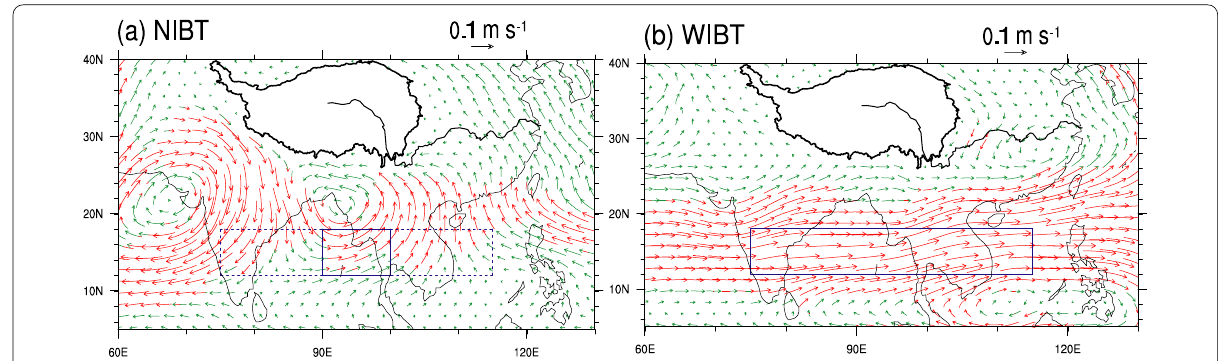
Fig. 2 Anomalous 700‑hPa winds (units: m s − 1 ) regressed upon the ( a ) NIBT and ( b ) WIBT indices in winter for the period 1979–2019, in which anomalous winds significant at the 99% confidence level are highlighted in red. The blue solid and dashed boxes in (a) and (b) represent the regions which are used to define the NIBT and WIBT